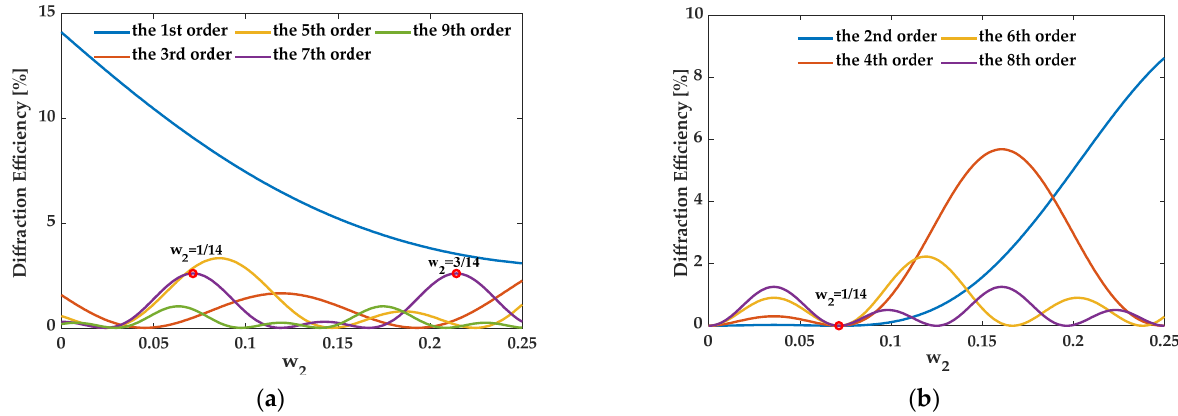
Figure 18. The diffraction efficiency of orders as a function of w 2 when { f i } is {1/14, 5/14, 1/14}. ( a ) The odd orders, ( b ) the even orders.